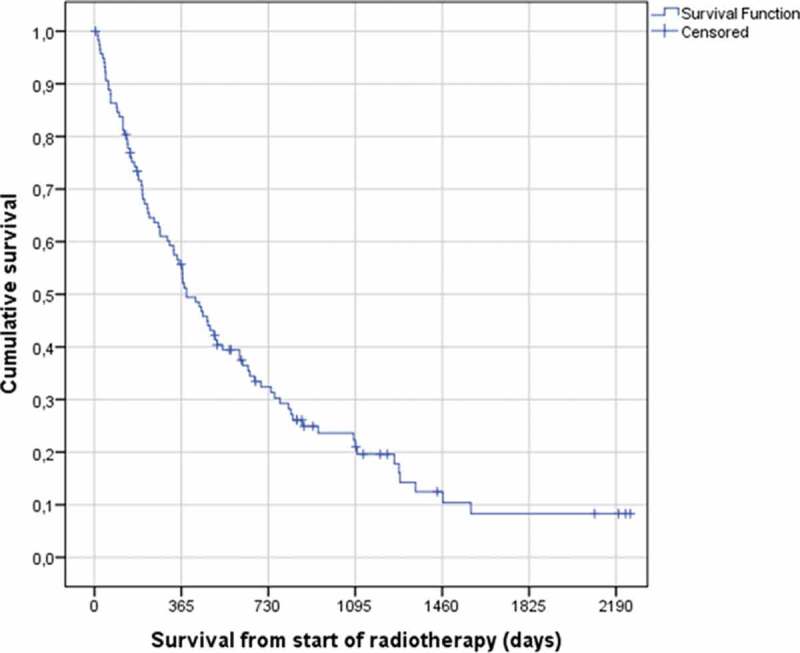
Actuarial Kaplan–Meier survival curve for 118 patients with bone metastases from breast cancer (median 12.7 months). Nearly 10% of the patients were still alive after 6 years.